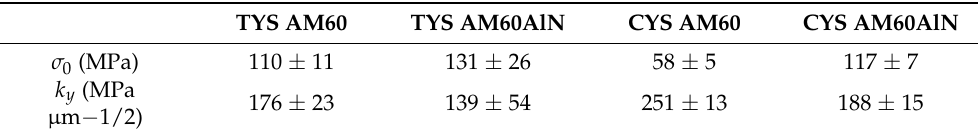
Table 2. Results of Hall–Petch relation (Equation (1)) for tension and compression tests of AM60 and AM60AlN alloys, where σ y is the yield stress, σ 0 is the friction stress that allows dislocations to move on slip planes in a single crystal in the absence of any strengthening mechanisms, k y is the stress concertation factor and D is the average grain